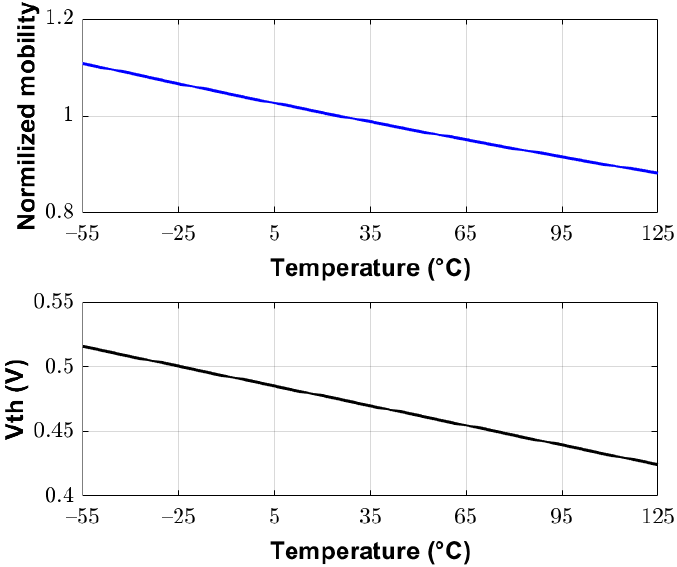
Figure 4. Simulated thermal dependency of carrier mobility µ and threshold voltage V TH in the cadence environment, within the temperature range of − 55 and 125 °C, for TT corner, using a 55 nm CMOS technology.